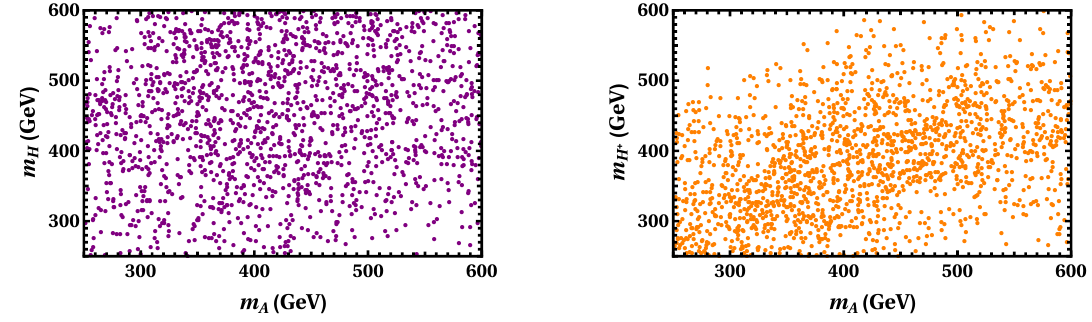
Figure 1 . Scanned points plotted in m A – m H (left) and m A – m points satisfy the tree level unitarity, perturbativity and positivity conditions as well as the T parameter constraint. However, not all points lead to the strong first-order